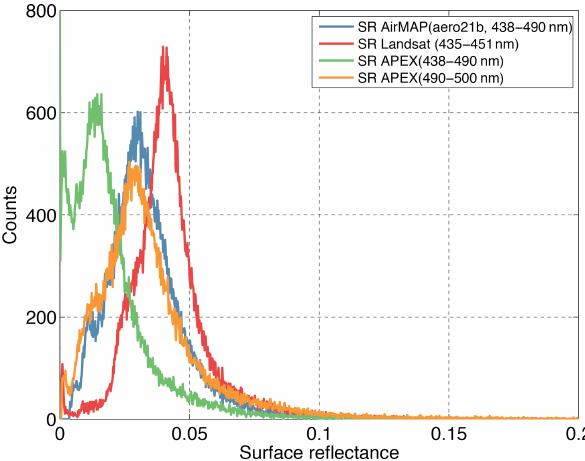
Figure 7. Histogram of surface reflectances from AirMAP, APEX, and Landsat 8 for the afternoon flight over Berlin on 21 April